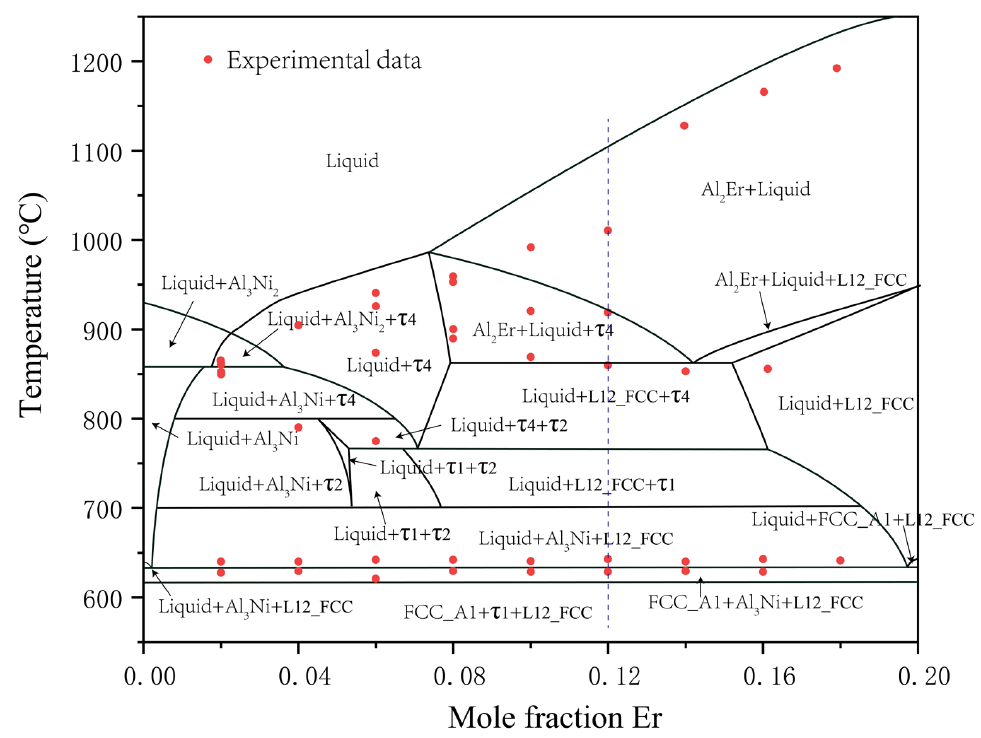
Figure 14. Calculated vertical section of the Al–Ni–Er phase diagram at Al 0.8 Ni 0.2 –Al 0.8 Er 0.2 with experimental dots indicating DSC thermal events. Table 4. Temperatures corresponding to thermal events recorded with DSC.